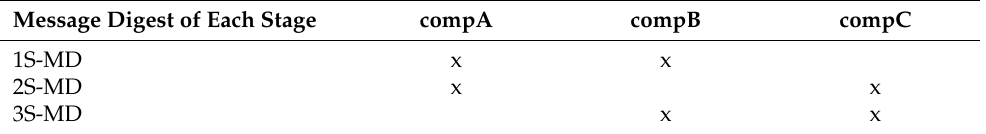
Table 1. Resulting signals of the comparators for each pair of stage message digests.